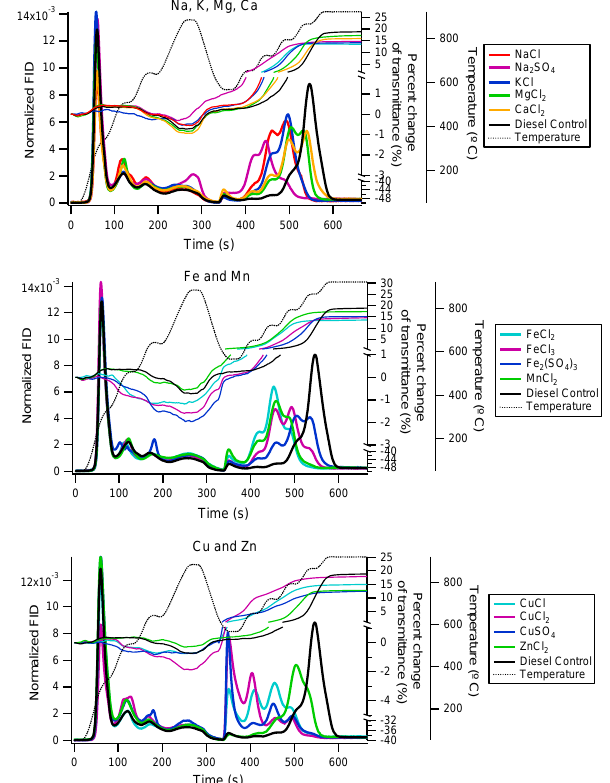
Fig. 2. Carbon evolution profiles of diesel and metal-loaded diesel samples using the NIOSH protocol. For each metal salt, several samples with different metal to carbon ratios were averaged. The diesel control profile is also an average, of 13 samples. The FID response was normalized to the total FID response ( 1 FID/ 6 FIDdt). Transmittance profiles are shown as percent change relative to the initial transmittance I 0 , i.e. (lnI-lnI 0 /ln I 0 ) ×